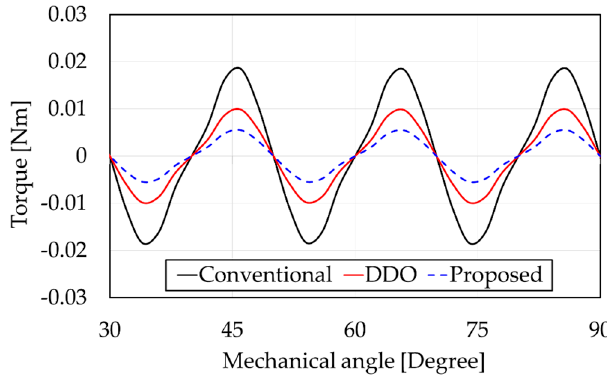
Figure 8. Cogging torque characteristic comparison.